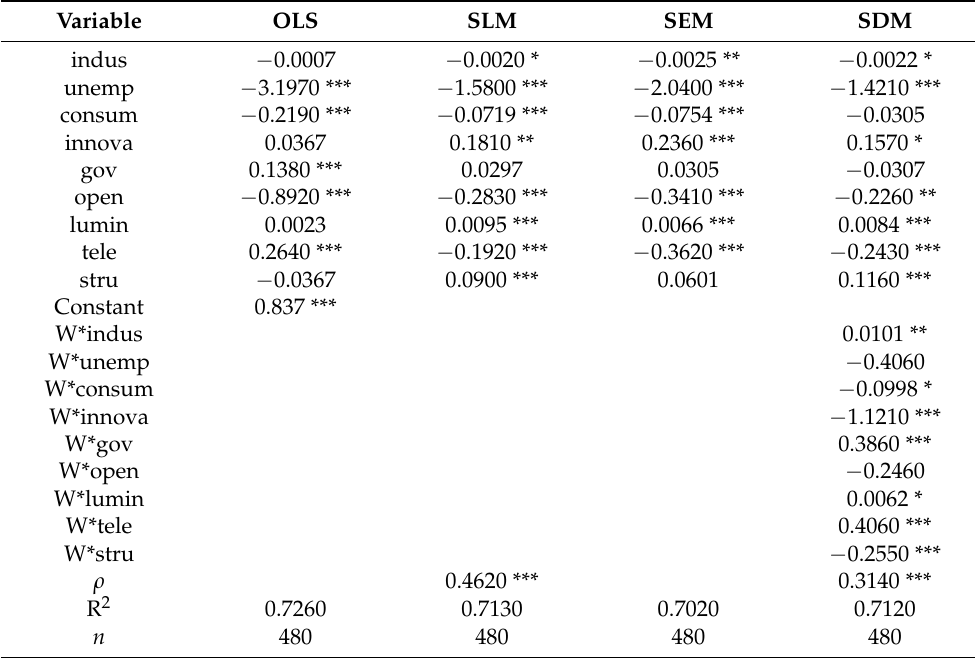
Table 3. OLS regression results with different spatial